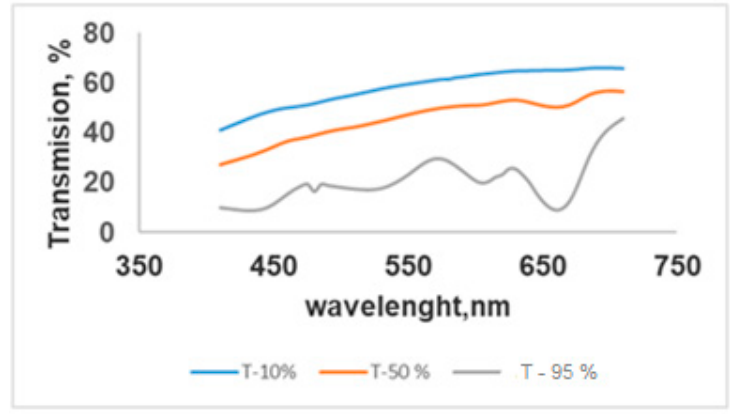
Figure 1. Transmission spectra for ethanol extracts of Sempervivum tectorum L. Table 3. Content of pigments in ethanol extracts.